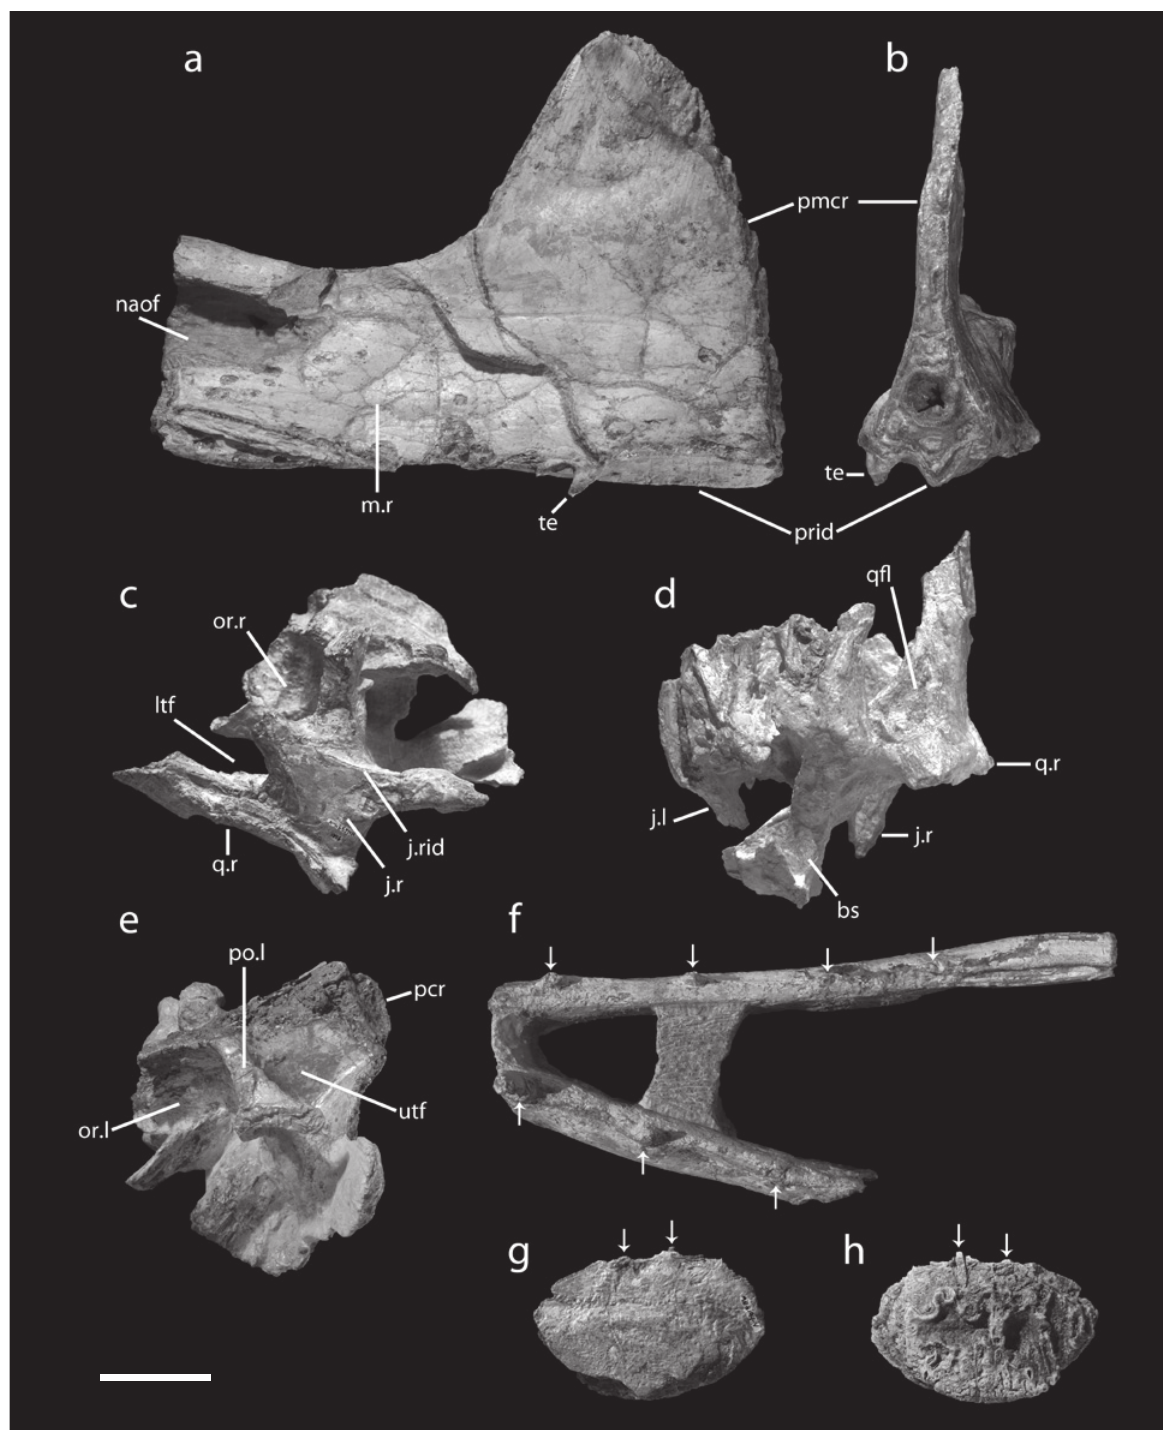
Fig 1. - Skull elements of Tropeognathus cf. T. mesembrinus (MN 6594-V). (a) Incomplete rostrum in right lateral view. (b) Incomplete rostrum in anterior view. (c) Posterior lower portion in right lateral view. (d) Posterior lower portion in posterior view. (e) Braincase in left lateral view. (f) Mandible in dorsal view. (g) Fragment of lower jaw in lateral view. (h) Fragment of lower jaw in medial view. Arrows indicate alveoli and teeth. See text for abbreviations. Scale bar 50